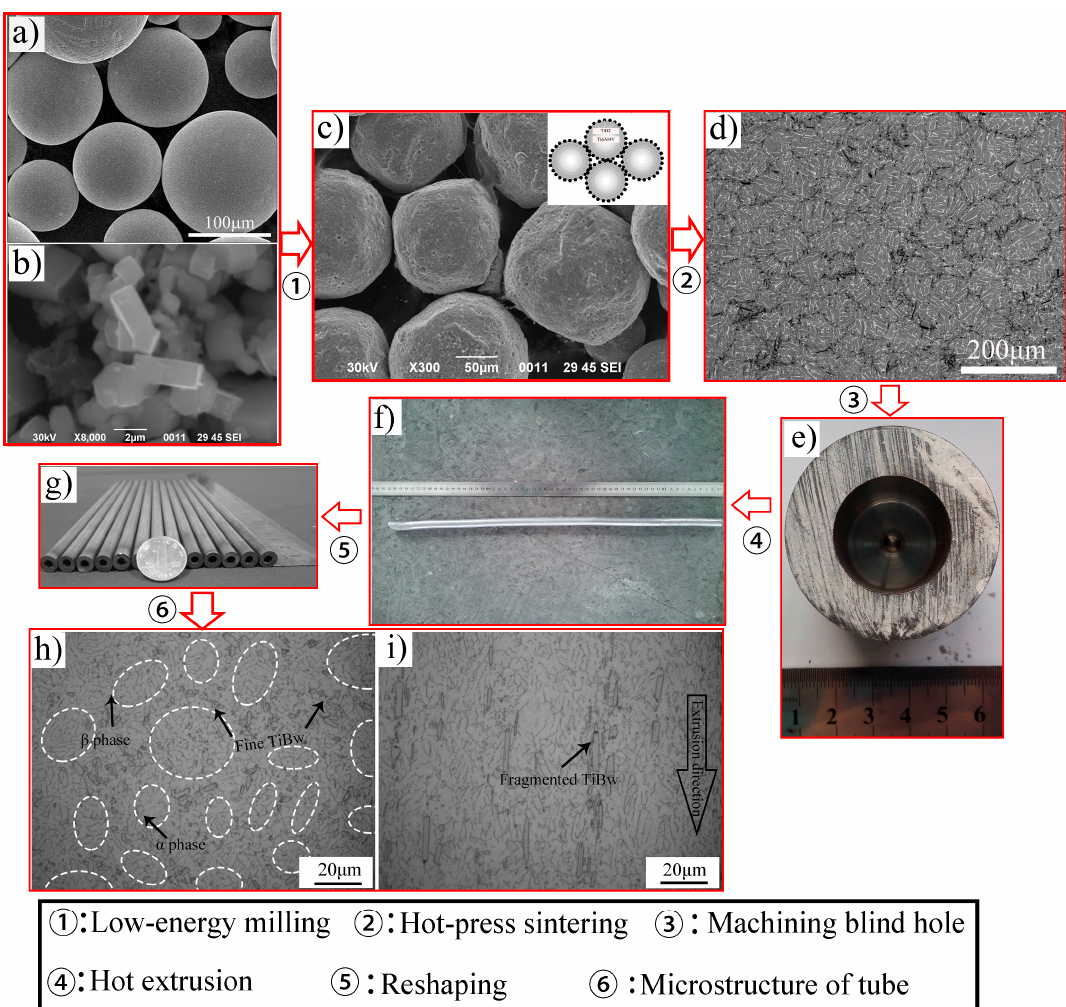
Figure 9. Micrographs evolution of TiBw/Ti6Al4V composite tubes: ( a ) Ti6Al4V powders; ( b ) TiB 2 powders; ( c ) the blended powders; ( d ) the sintered microstructure; ( e ) the extruded billet; ( f ) the extruded tube; ( g ) the finished production; ( h ) the cross-section microstructure of the composite tube; ( i ) the longitudinal section microstructure of the composite tube. Table 4. The oxygen content of different stages (wt. %).